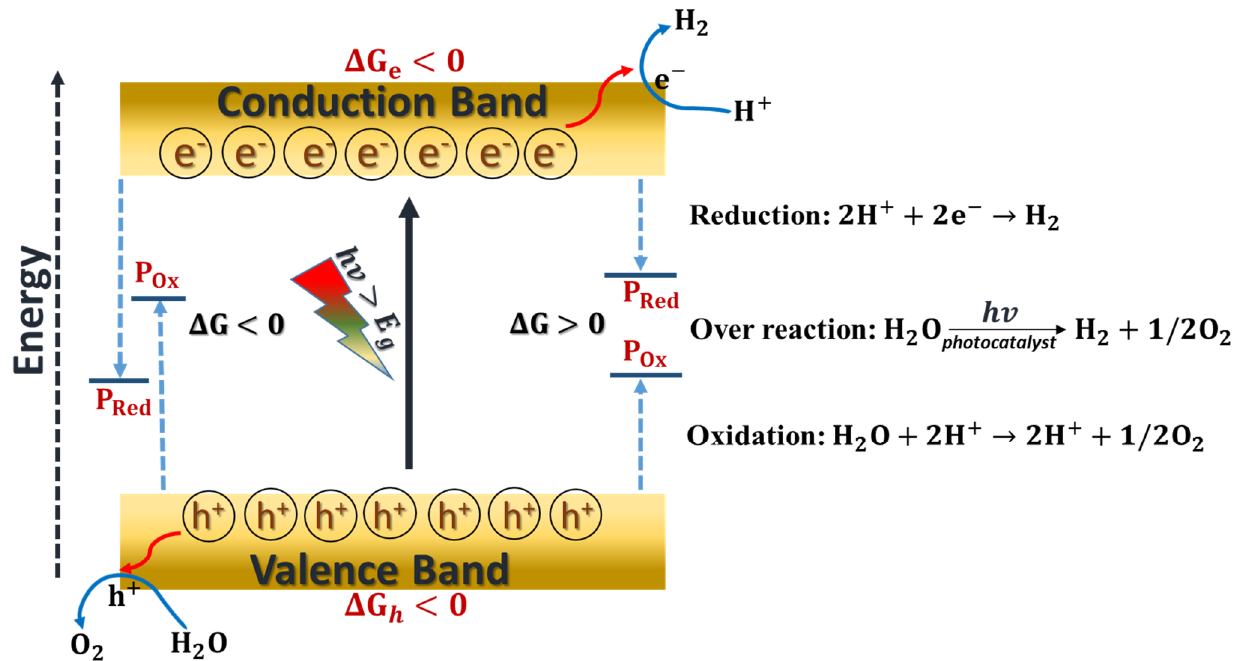
Figure 1. A schematic diagram of the band alignment of a semiconductor photocatalyst.